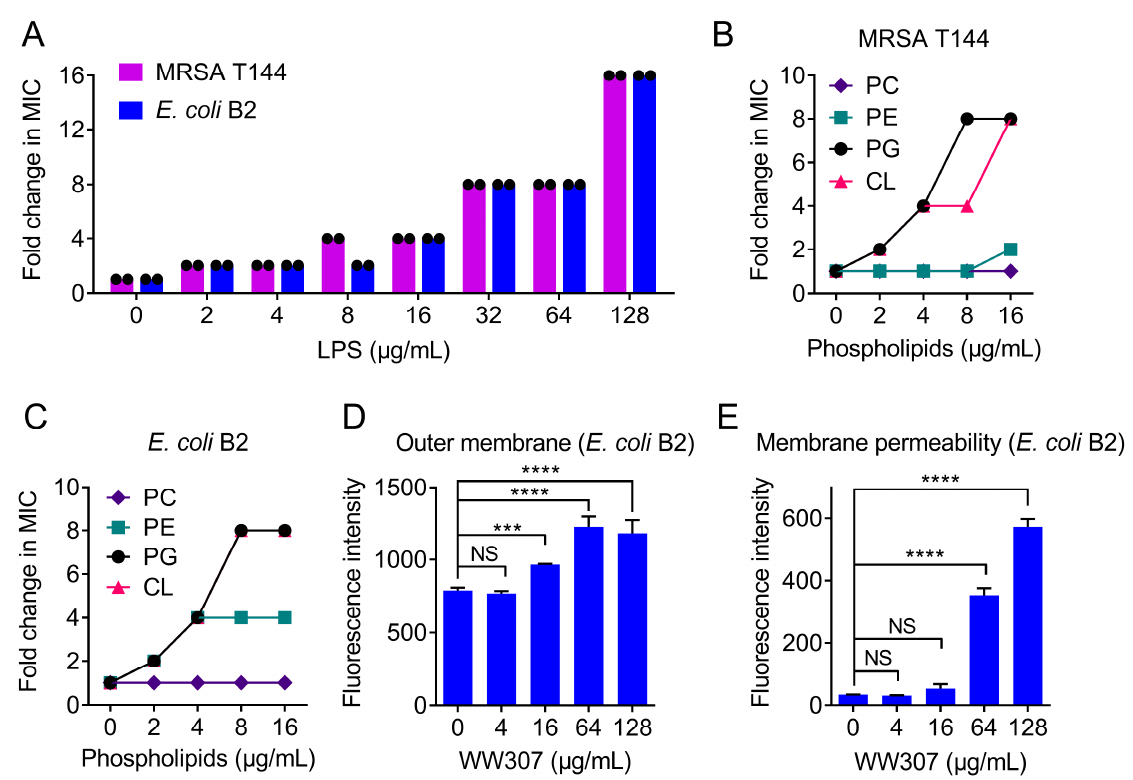
Figure 7. WW307 disrupts bacterial membrane permeability by specifically targeting lipopolysaccharide (LPS) and various phospholipids. ( A ) Exogenous addition of LPS deriving from E. coli O111:B4 impaired the antibacterial activity of WW307 against MRSA T144 and E. coli B2 in a dose-dependent manner. ( B , C ) Increased MICs of WW307 against MRSA T144 and E. coli B2 in the presence of PG, CL and PE. The 96-well plates were incubated at 37 ◦ C for 16-18 h for MIC analysis. ( D , E ) WW307 disrupted the outer membrane and whole cell membrane permeability of E. coli B2, which were assessed by fluorescence probes 1- N -phenylnaphthylamine (NPN, excitation 350 nm and emission 420 nm) and propidium iodide (PI, excitation 535 nm and emission 615), respectively. Bacterial cells were incubated with fluorescent probes at 37 °C for 30 min in dark, then different concentrations of WW307 (0–128 μ g/mL) was added and incubated at 37 °C for 1 h. All data were presented as mean ± SD, and the statistical significance was determined by non ‐ parametric one ‐ way ANOVA (NS, not significant; *** p < 0.001, **** p < 0.0001).